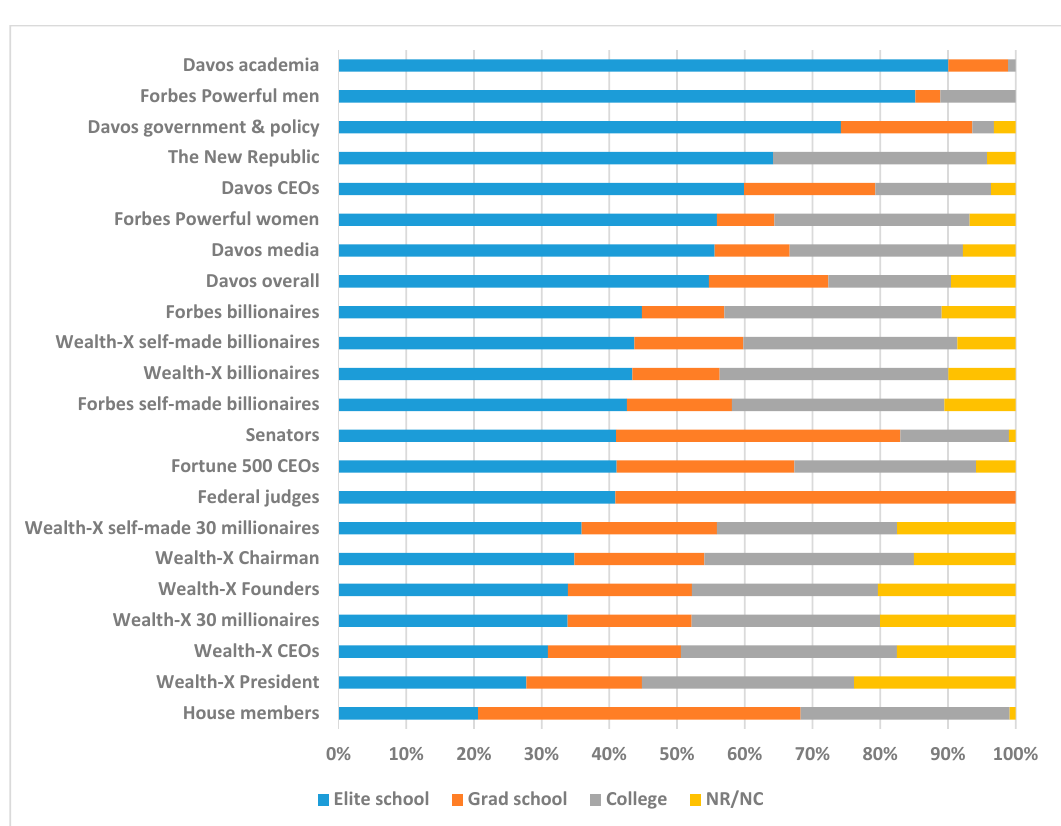
Figure 2. Elite school attendance and general ability level of U.S. occupationally select groups. Blue bars: The percentage of each occupationally selective U.S. group that attended an “Elite school” (undergraduate or graduate) and were in the top 1% of general cognitive ability. Orange bars: The percentage that attended a “Grad school” independent of the Elite school category. Gray bars: The percentage attending “College” independent of the Grad school and Elite school categories. Yellow bars: The percentage that did “not report” or had “no college.” Elite school + Grad school + College + NR/NC sum to 100%. Data were taken from multiple research papers and adapted for this figure focused on the U.S. [53,54,56,57].